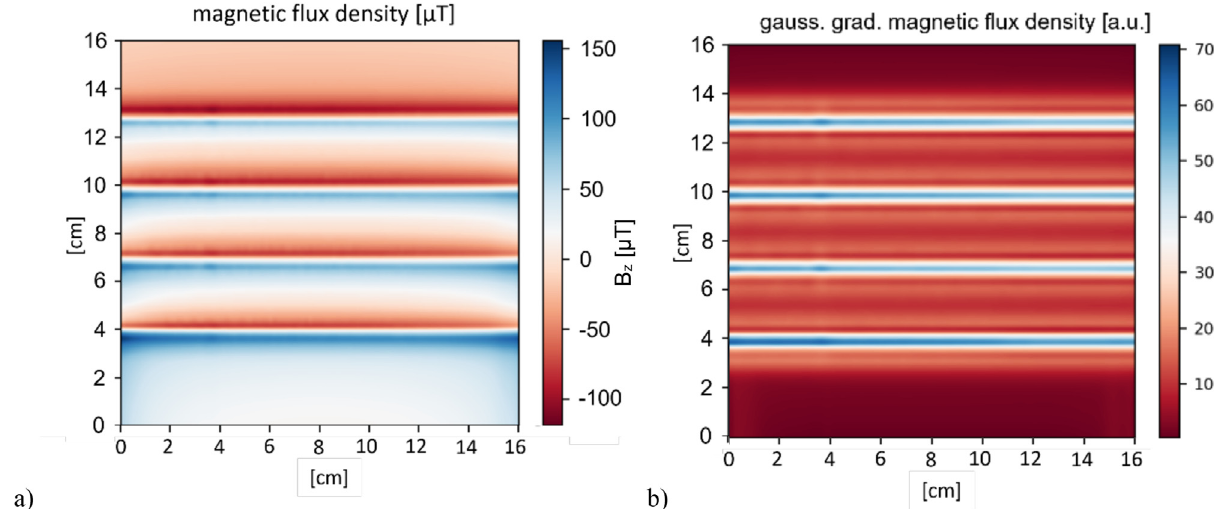
Fig. 3. Magnetic fl ux density B z component of a simulated solar cell (a) and the same simulation with an applied Gaussian gradient fi lter